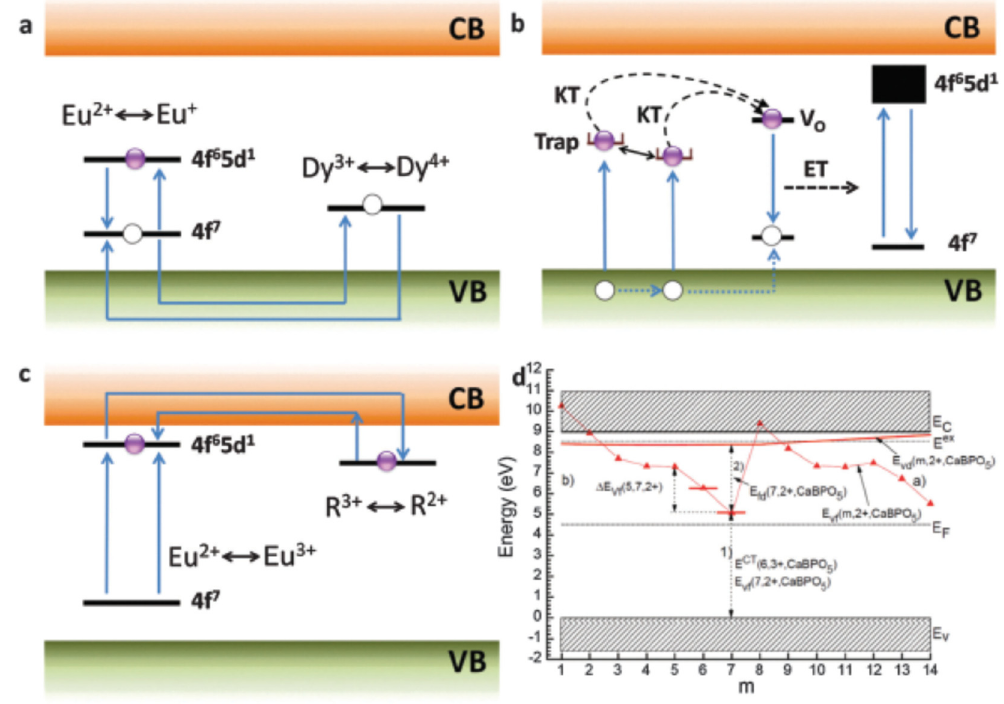
Figure 7. ( a ) Hole model: Afterglow mechanism proposed by Matsuzawa et al. for SrAl 2 O 4 : Eu2+ ,Dy 3+ . ( b ) Electron model: Afterglow mechanism proposed by Aitasalo et al. for CaAl 2 O 4 :Eu 2+ ,Dy 3+ . ( c ) Persistent phosphorescence mechanism proposed by Dorenbos et al. for aluminate and silicate compounds. ( d ) Energy level scheme of the divalent lanthanides in CaBPO 5 . Reproduced with permission from [25] with permission from The Royal Society of Chemistry.